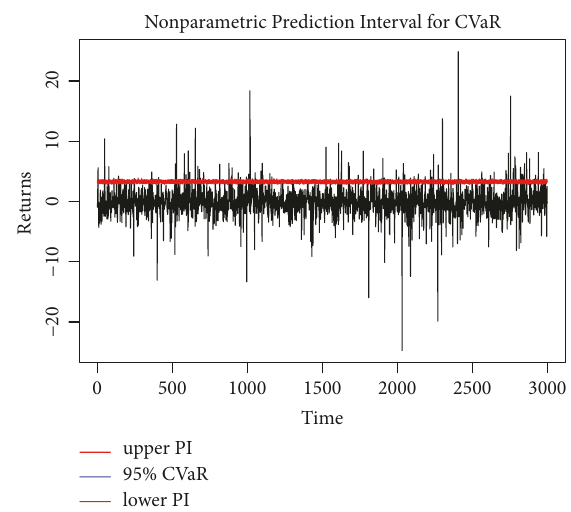
Figure2:Graphshowingthe95%ConditionalValue-at-Riskinblue color, while the upper and lower prediction intervals are in red